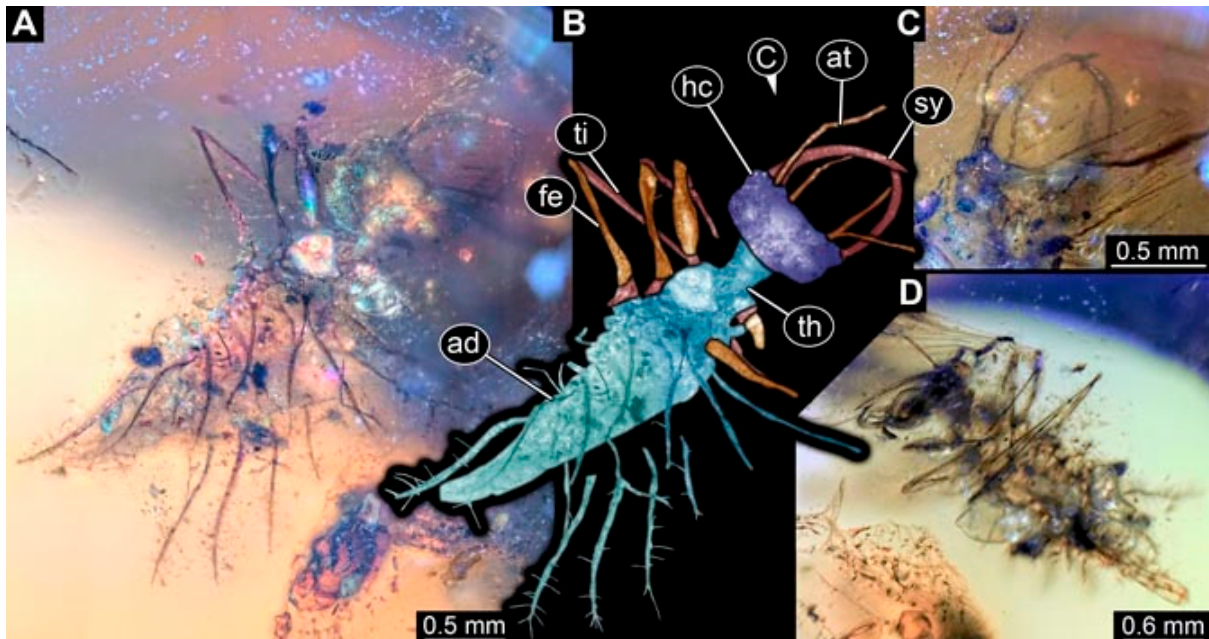
Figure 16. Two specimens in Myanmar amber. ( A – D ) Specimen 4836 (PED 0315). ( A ) Dorsal view. ( B ) Dorsal view, colour-marked. ( C ) Ventral view. ( D ) Close-up of trunk appendage with empo- dium (arrow). ( E – H ) Specimen 4837 (PED 0323). ( E ) Dorsal view. ( F ) Dorsal view, colour-marked. ( G ) Ventral view. ( H ) Close-up of trunk appendages with empodium (arrow). Abbreviations: ad = abdomen; at = antenna; fe = femur; hc = head capsule; lp = labial palp; sy = stylet; th = thorax; ti = tibia.